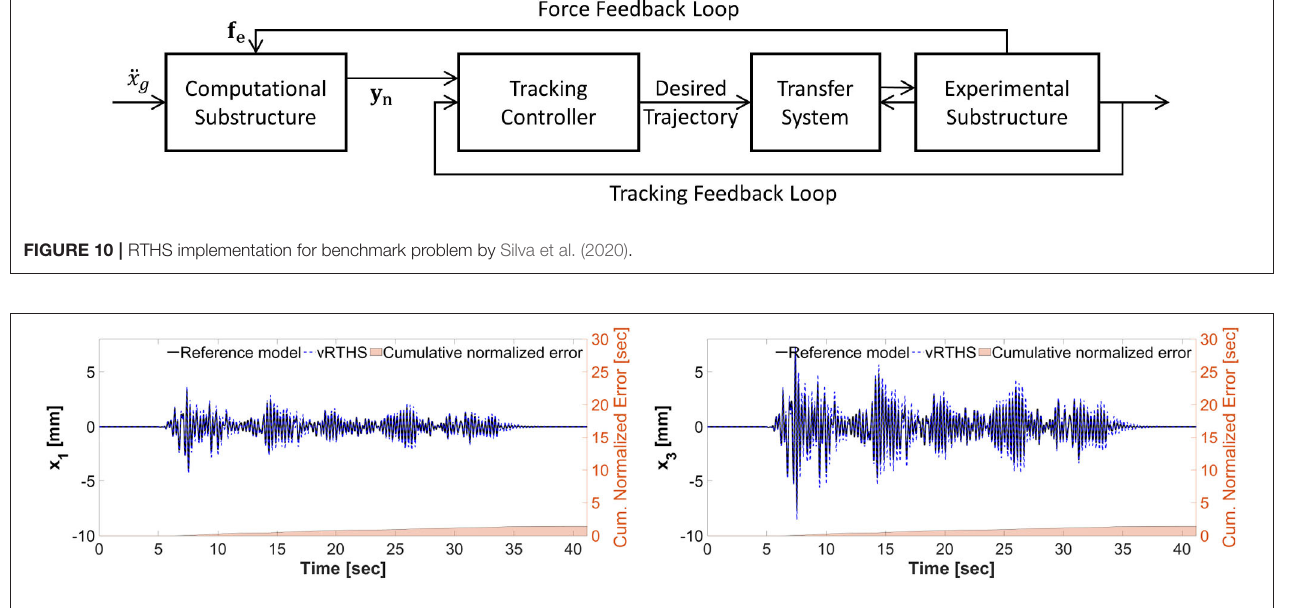
FIGURE 11 | Study 1 (Case 1): vRTHS response comparisons of the 1st and 3rd floor displacements under El Centro excitation.